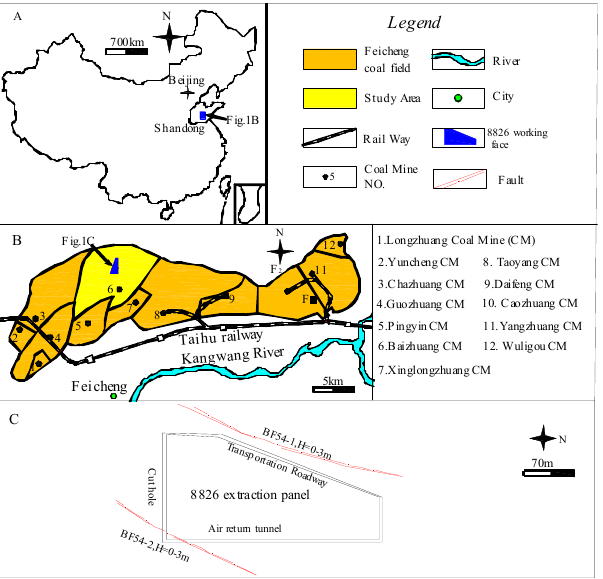
Figure 1. Location of the study area in China, including ( A ) the Feicheng coal field within China and ( B ) the location of the Baizhuang CM within the Feicheng coal field. ( C ) Schematic of the 8826 extraction panel.